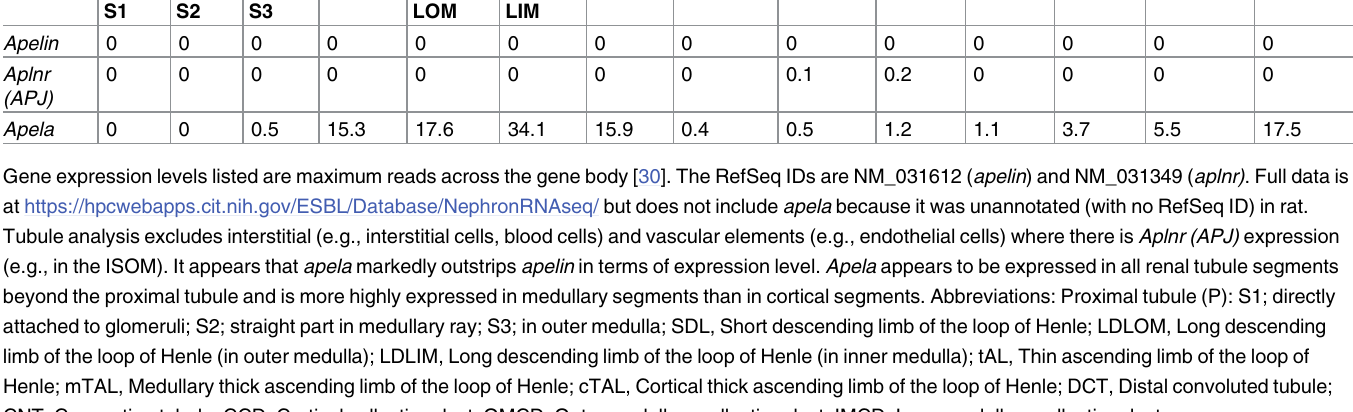
Table 1. Relative mRNA abundance for apela , apelin and aplnr quantified by RNA-Seq in microdissected rat kidney tubules. P